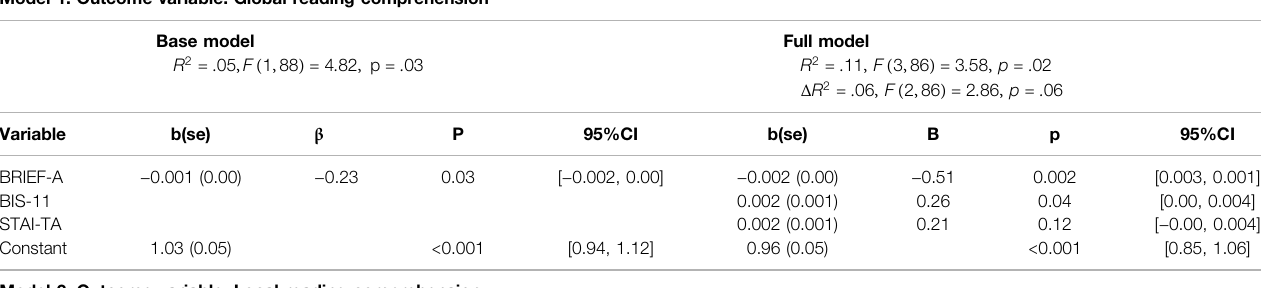
TABLE 2 | 1 Hierarchical regression model with global and local reading comprehension as the outcome variables and general EFs, impulsivity, and anxiety as independent variables. Model 1: Outcome variable: Global reading comprehension Base